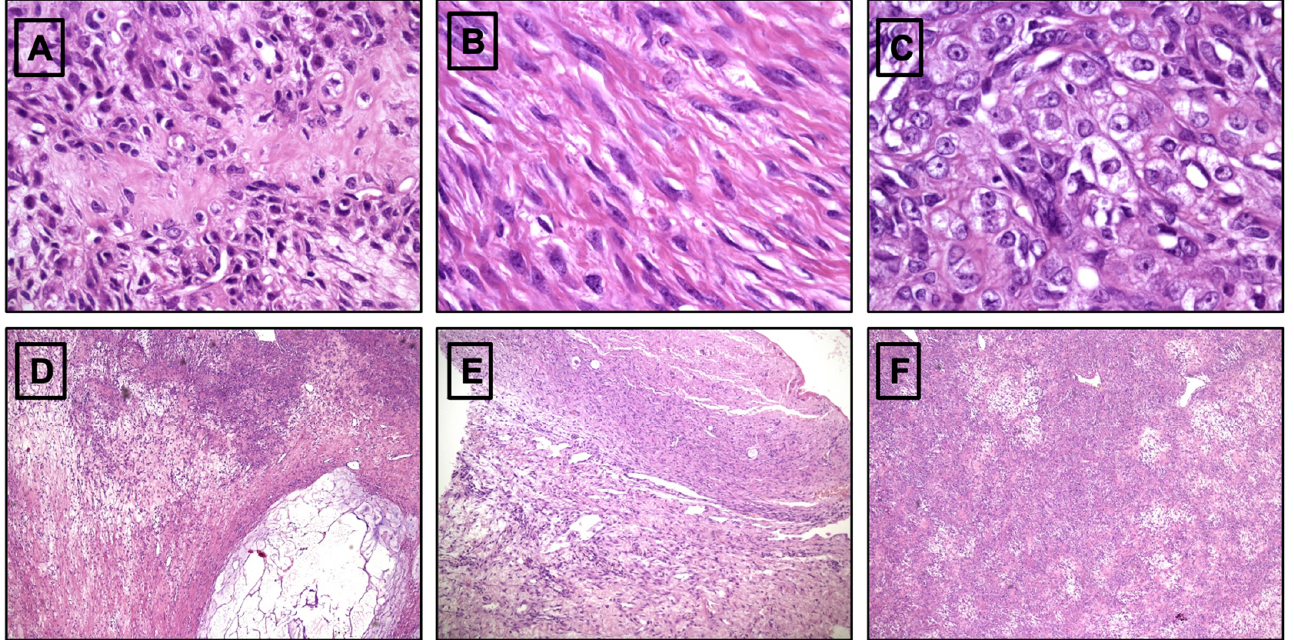
Figure 2. ( A ) Spindle and round cells intermingled together in a hyaline stroma (asterisk) (HE, 40×); ( B ) Fascicular spindle cell proliferation (HE, 63×); ( C ) Proliferation of round, epithelioid clear cells (arrowhead) (HE 63×); ( D ) A clear gelatinous area is observed (arrow) (HE, 5×); ( E ) A rim of residual ovarian parenchyma is shown in the upper part of the picture (rectangle) (HE, 10×); ( F ) Alternation of hyper ‐ and hypocellular areas in the same tumor (“dark” and “clear” proliferation pattern) (HE, 5×).